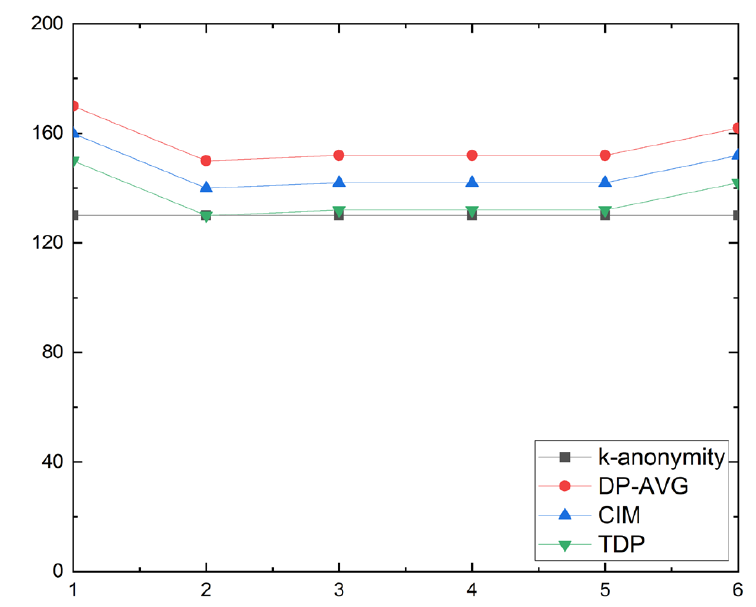
Figure 10. MSE comparison diagram for Geolife Trajectories dataset (using k -anonymity and TDP ).